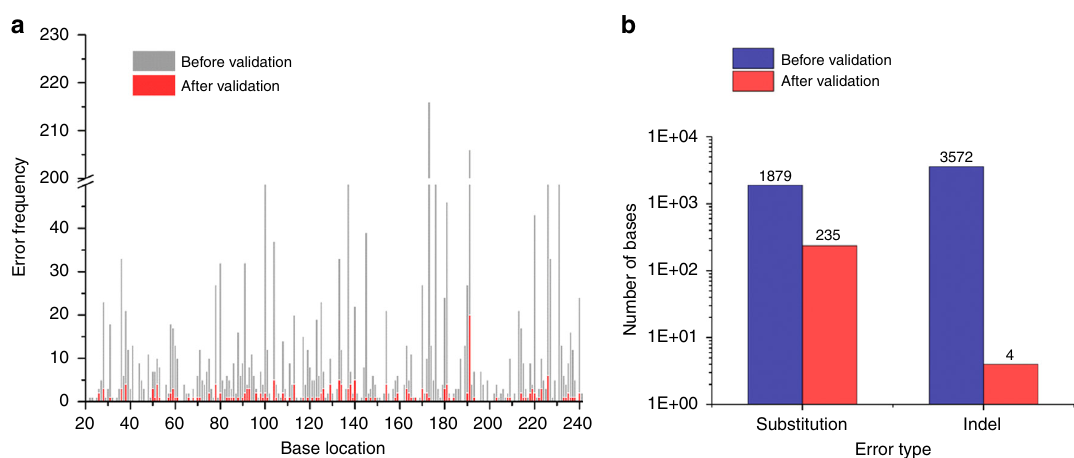
Fig. 4 Identi fi cation of PCR-induced error through the barcode-free NGS error validation. a Distribution of NGS and PCR-induced errors in the template sequence. PCR-induced error was randomly distributed while NGS error frequently occurred at homopolymer sequence (e.g. 173rd and 191st base) ( n = 2,197,356 bases). b Veri fi cation of true variants according to error type. 235 of 1879 substitutions and 4 of 3572 indels were true variants (including primer region) after NGS error validation. Source data are provided as a Source Data fi le